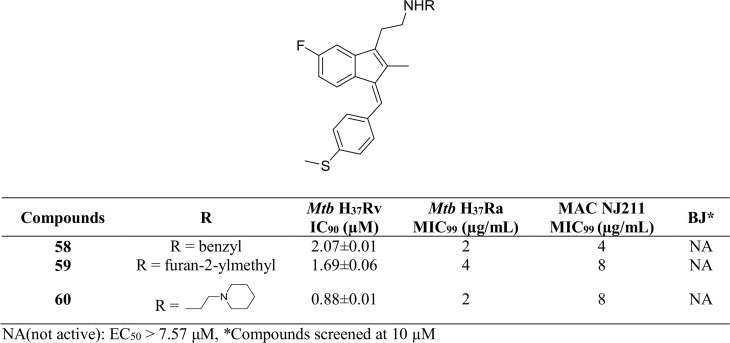
Mtb H37Rv and BJ cell data of Sulindac sulfide amine derivatives 58–60.